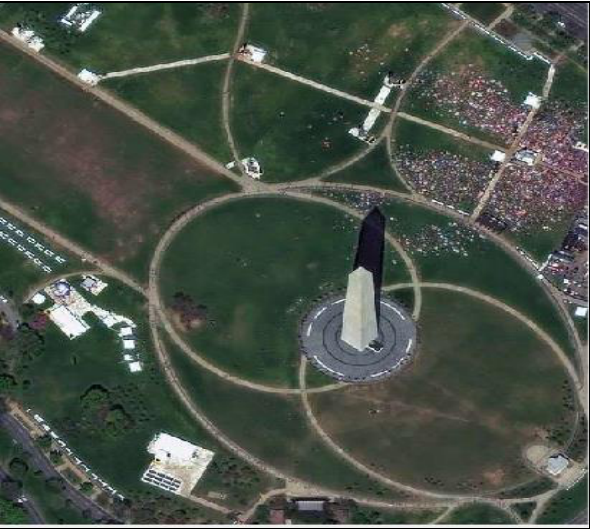
Figure 2. Original image